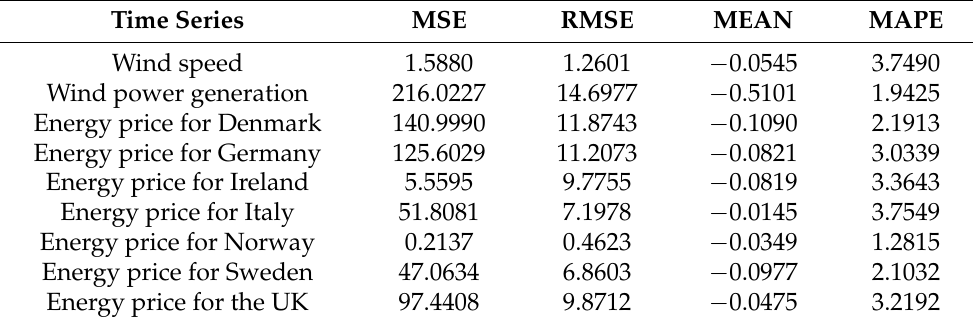
Figure 14. Comparison of energy price time series forecasting for six different countries. Table 2. Statistical information for time series forecasting